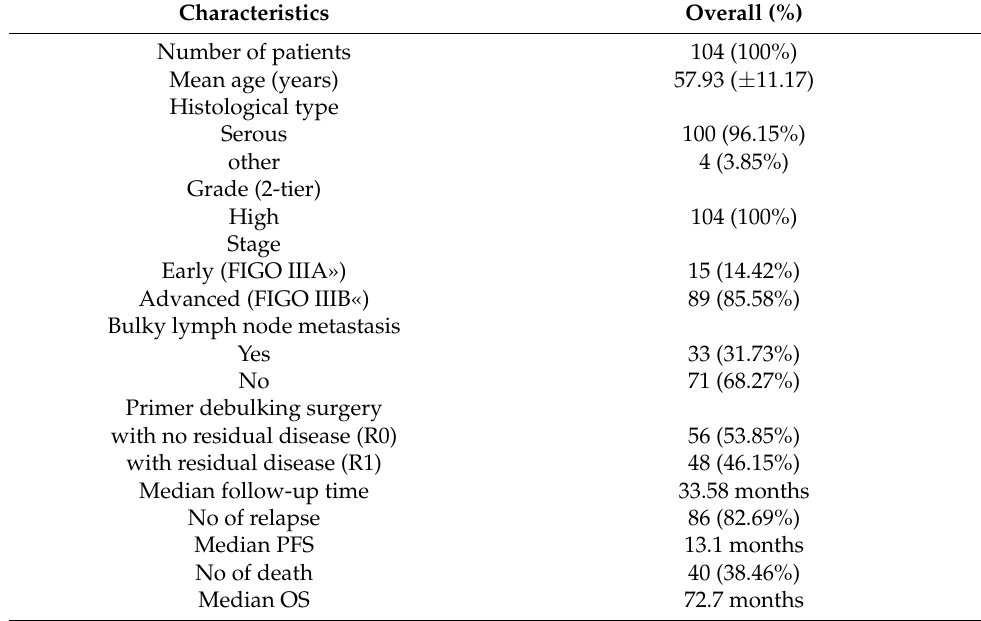
Table 1. Characteristics of